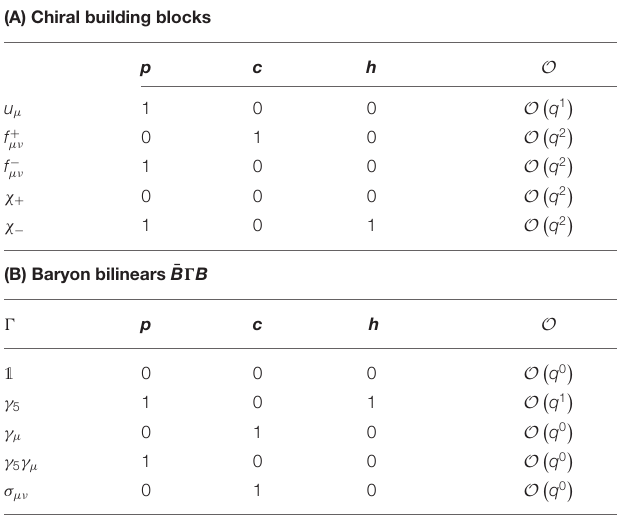
TABLE 2 | Behavior under parity, charge conjugation, and Hermitian conjugation as well as the chiral dimensions of chiral building blocks and baryon bilinears ¯ B Ŵ B